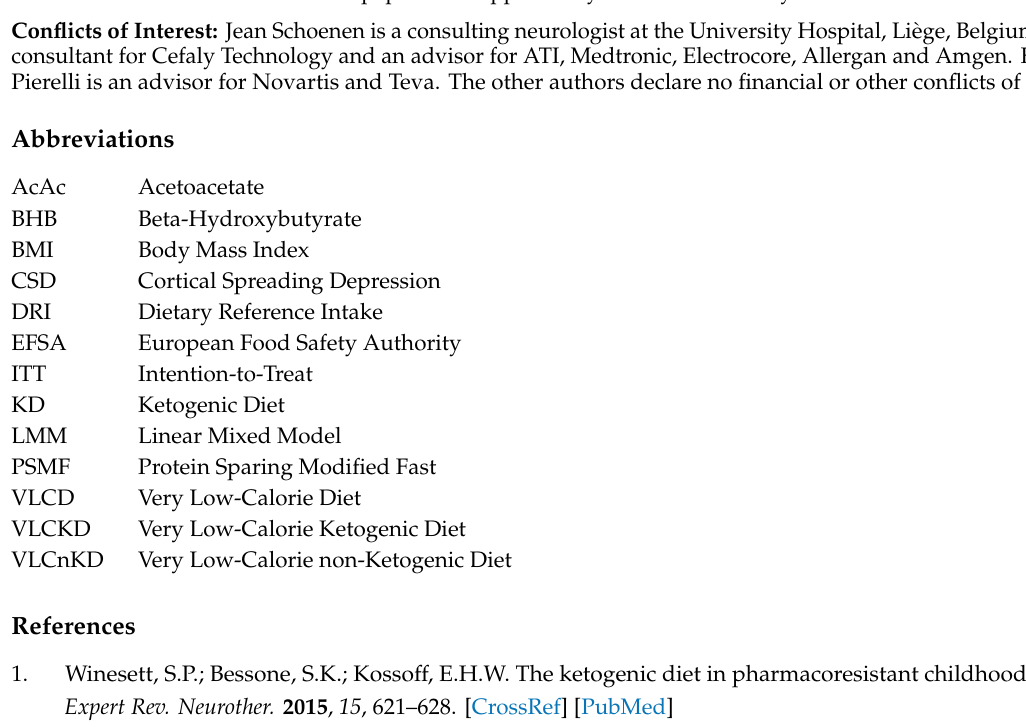
Table S1: Results of blood analysis at T0 (baseline), T1 (the end of the first month of very low-calorie diet) and T3 (the end of the second month of very low calorie diet). Figure S1: Profiles of averages. Means and standard errors of means from T1 to T5 of clinical variables in “R ≥ B” and “B ≥ R” groups. The two VLCD periods were between T1 and T2 and between T3 and T4. Red line indicates VLCKD; blue line indicates